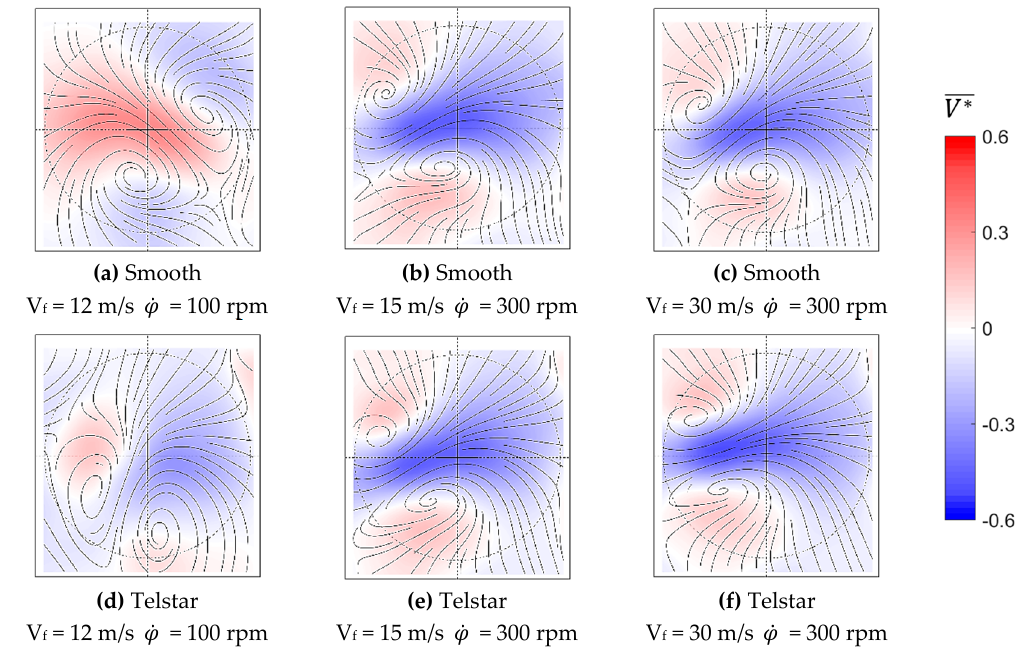
Figure 4. Averaged normalised V velocity component through the measurement volume for a range of conditions. The streamlines are based on the averaged V and W velocity